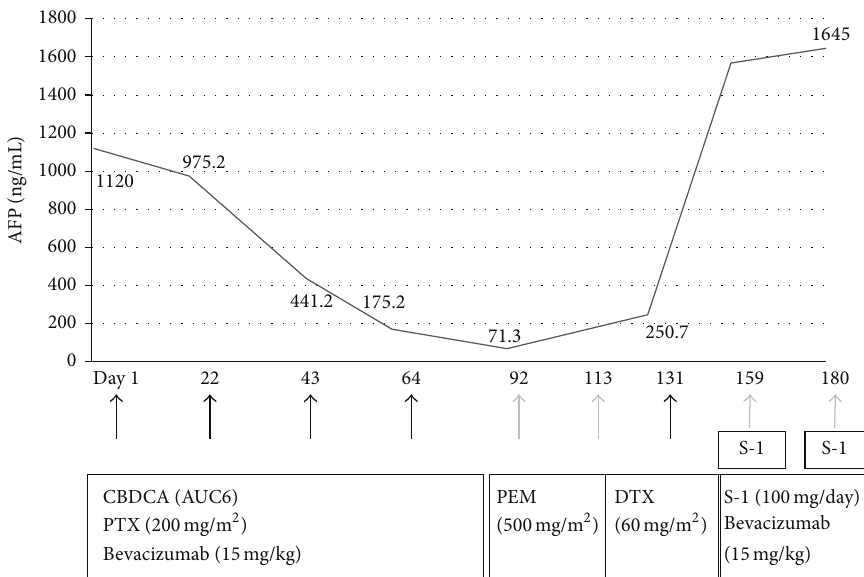
Figure 3: Clinical course showing decreased levels of AFP after the serial courses of chemotherapy with carboplatin and paclitaxel plus bevacizumab. After the recurrence, levels of AFP rapidly increased regardless of latter treatment with pemetrexed (PEM), docetaxel (DTX), and S-1 plus